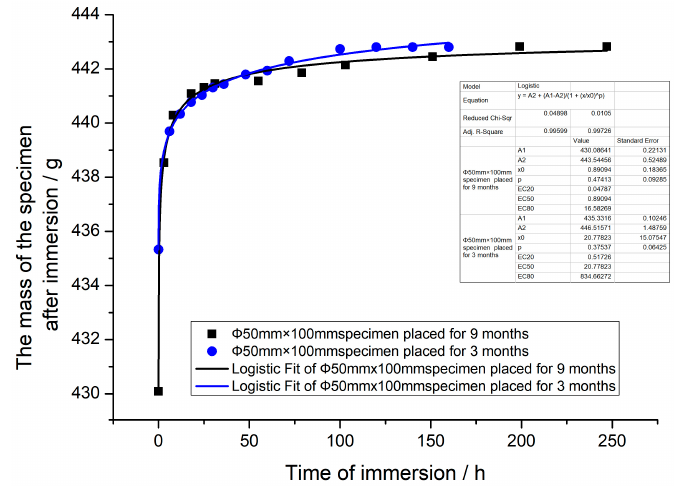
Figure 3. Variation of mass with immersion time for specimens of the same size placed in a dry room for different times after immersion.